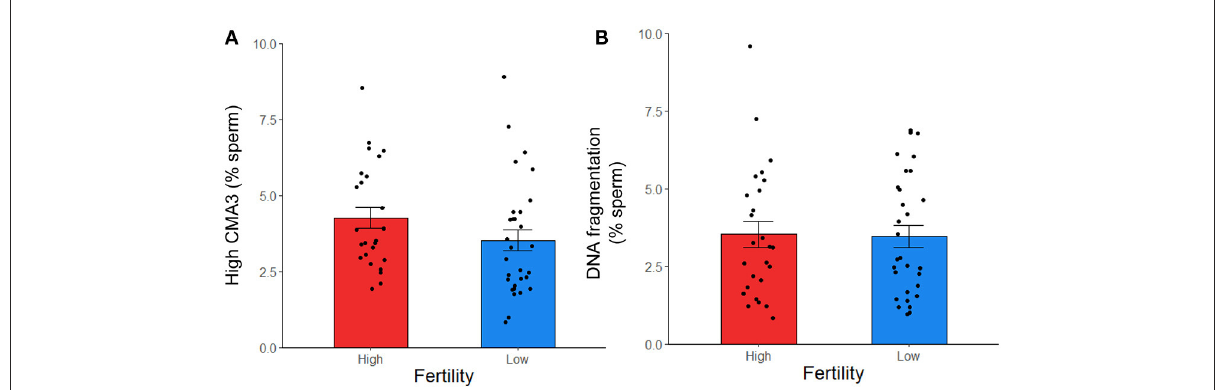
FIGURE6 Protamine deficiency (high CMA3) (A) and DNA fragmentation (B) in frozen-thawed spermatozoa from HF ( n = 10 bulls; with the exception of high CMA3, where n = 9) and LF ( n = 10) bulls, assessed with CMA3 and AO, respectively. Each data point represents an individual ejaculate from a bull. No differences between HF and LF was observed for these attributes ( p > 0.05).